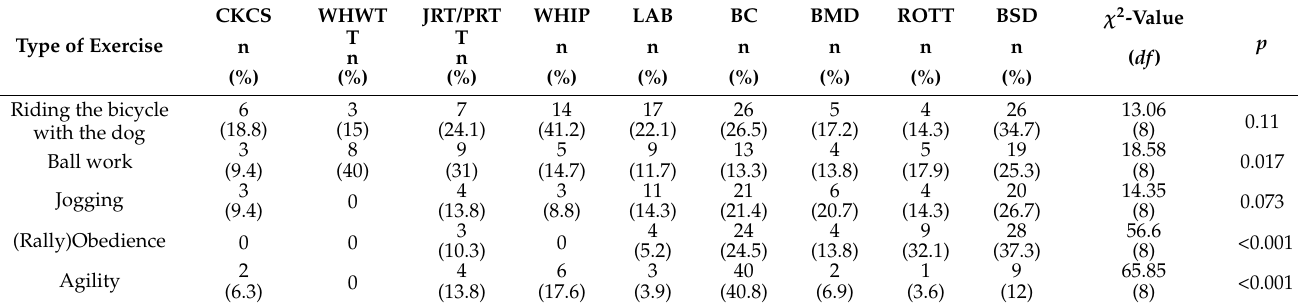
Figure 5. Leisure time walking in h/week (mean ± SD ) of owners of different dog breeds at baseline (T0), after 1 (T1), 2 (T2) and 3 (T3) years. BC, Border Collie; BERN, Bernese Mountain Dog; BSD, Belgian Shepherd Dog; CKCS, Cavalier King Charles Spaniel; JRT/PRT, Jack and Parson Russell Terrier; LAB, Labrador Retriever; ROTT, Rottweiler; WHIP, Whippet; WHWT, West Highland White Terrier. Table 3. Participation of owners of different dog breeds in different types of activities.